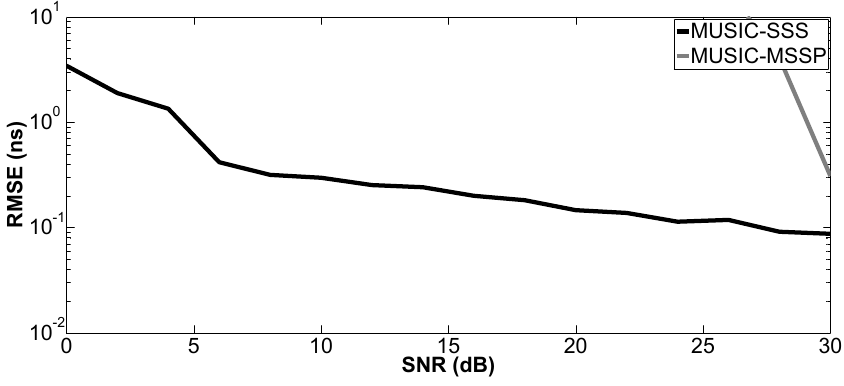
Figure 6. RMSE on the estimated time delay ˆ t M 1 versus